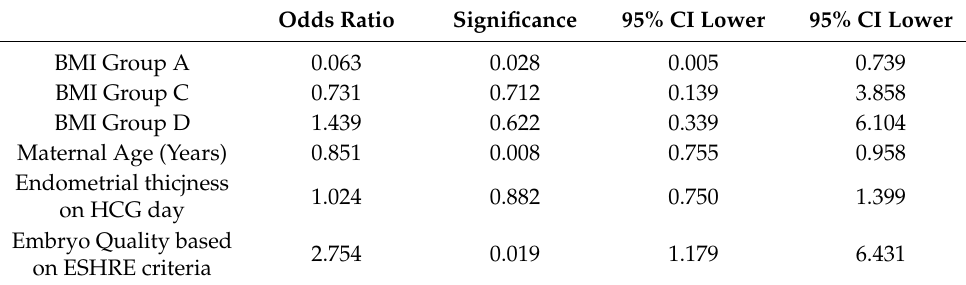
Table 4. Multivariate analysis of parameters affecting pregnancy